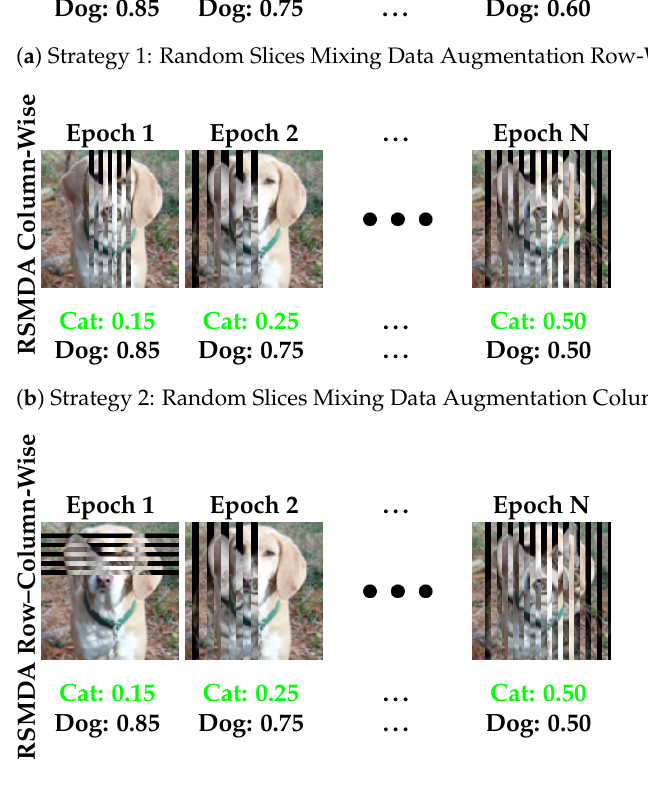
Figure 2. Three strategies for Random Slices Mixing Data Augmentation